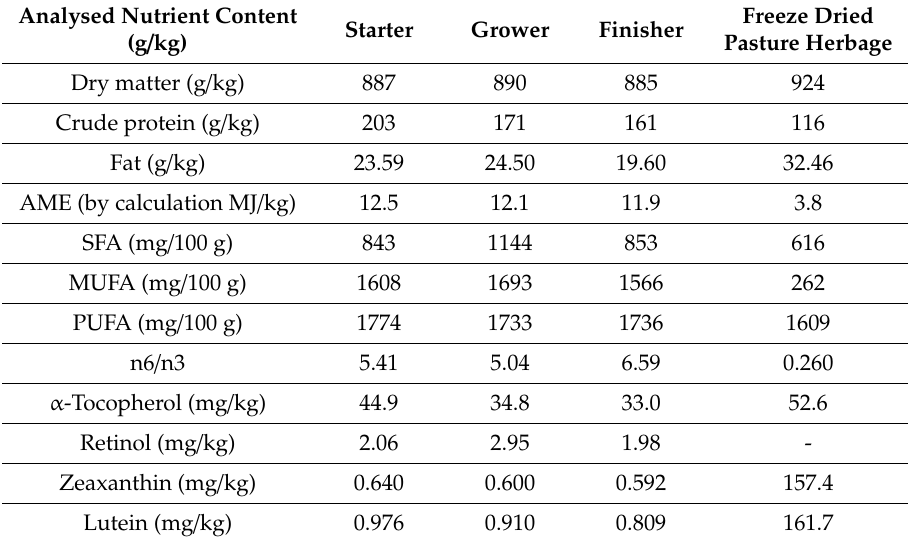
Table 2. Nutrient content of the diets and freeze-dried